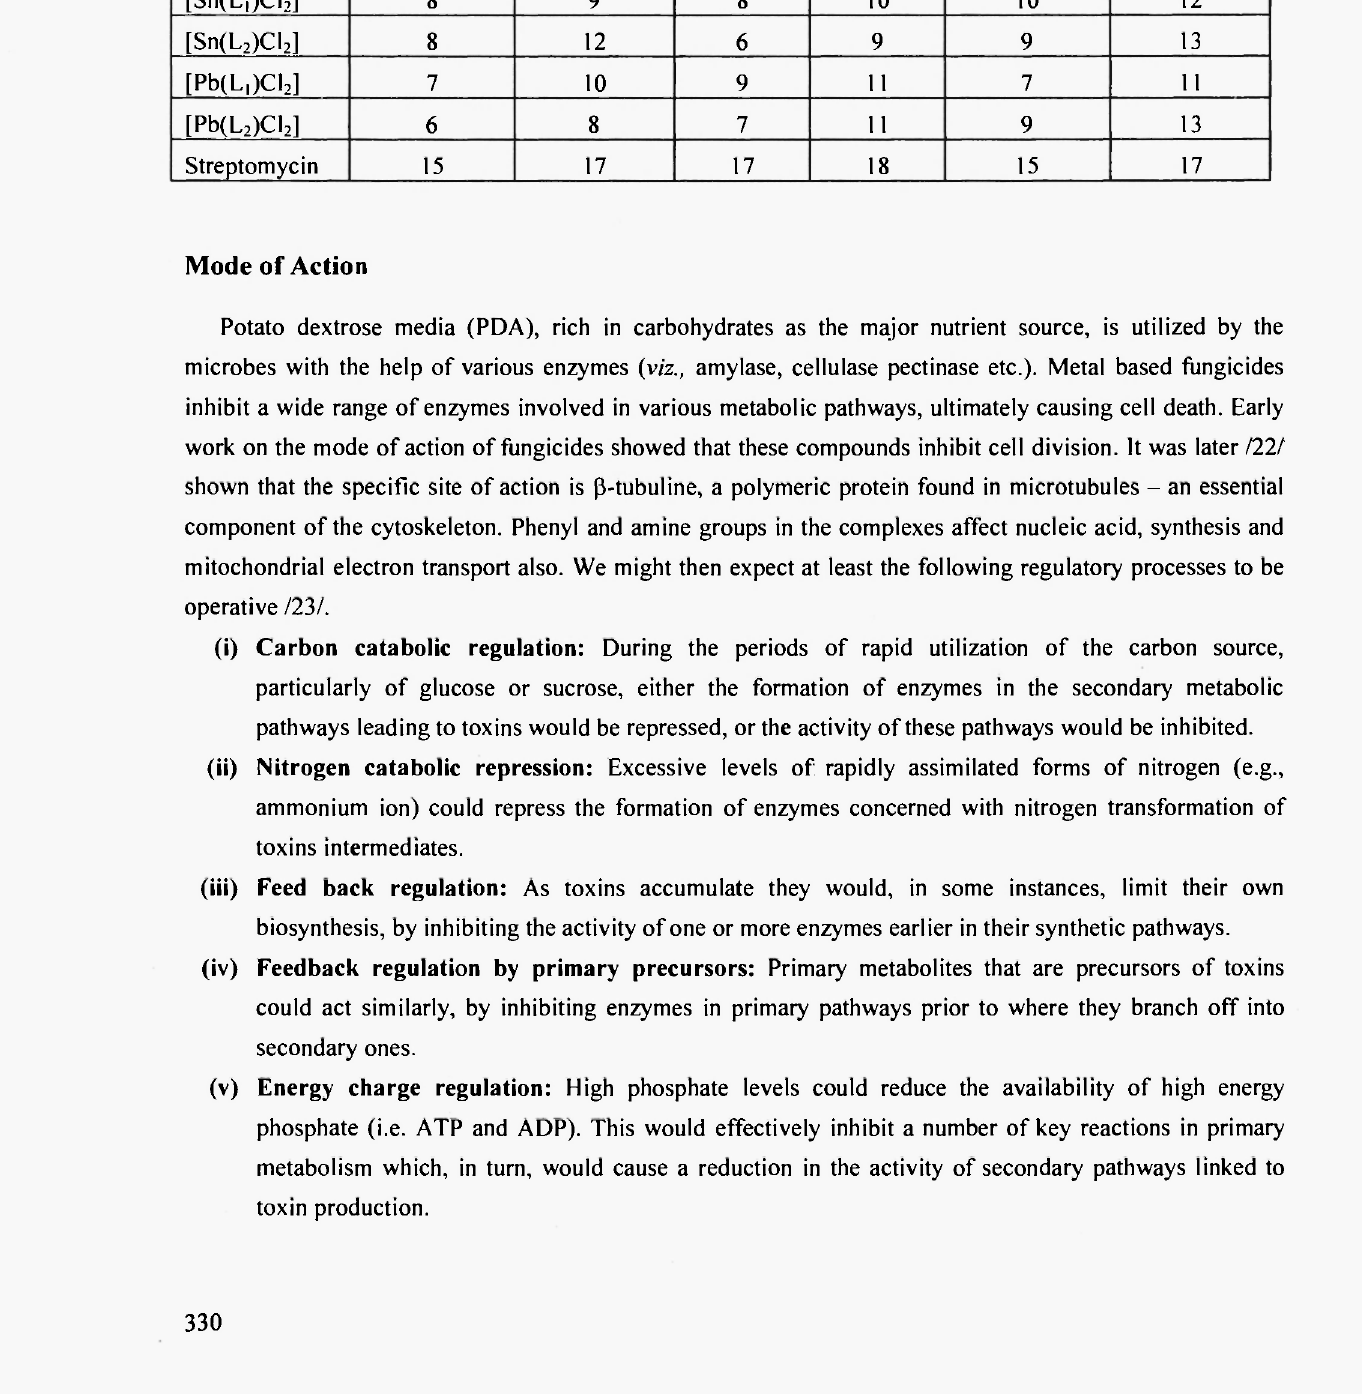
Compound Pseudomonas cepacicola